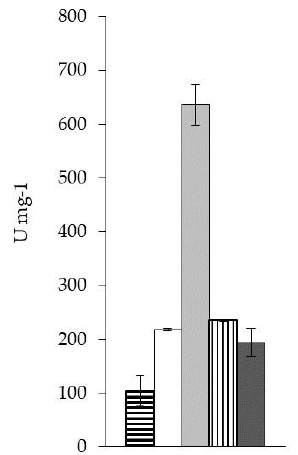
Figure 1. Specific activity of plant HRP Type VI-A with ABTS under various conditions. Five different buffers were used to measure the catalytic activity of plant HRP with 5 mM ABTS and 1 mM hydrogen peroxide. Horizontal stripes: 50 mM BisTris/HCl pH 7, 7% glycerol, 100 mM NaCl; white: 50 mM BisTris/HCl pH 7; light grey: 50 mM KH 2 PO 4 pH 5; vertical stripes: 50 mM KH 2 PO 4 pH 6.5; dark grey: 50 mM KH 2 PO 4 pH